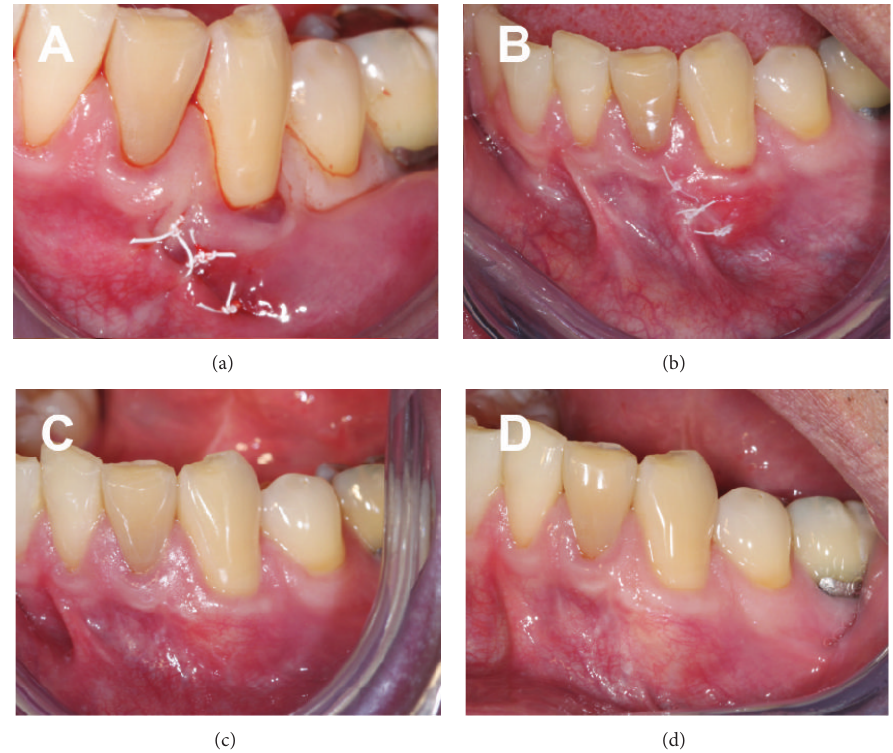
Figure 3: Clinical images. (a) Excisional biopsy completed; (b–d) postoperative appearance: 1 week (b), 3 months (c), and 12 months